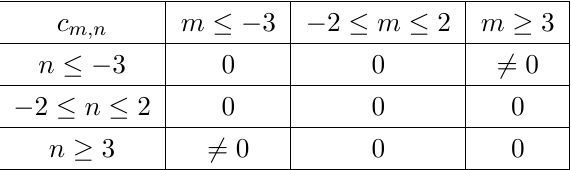
Table 1 . Values of c m,n for a given m and n